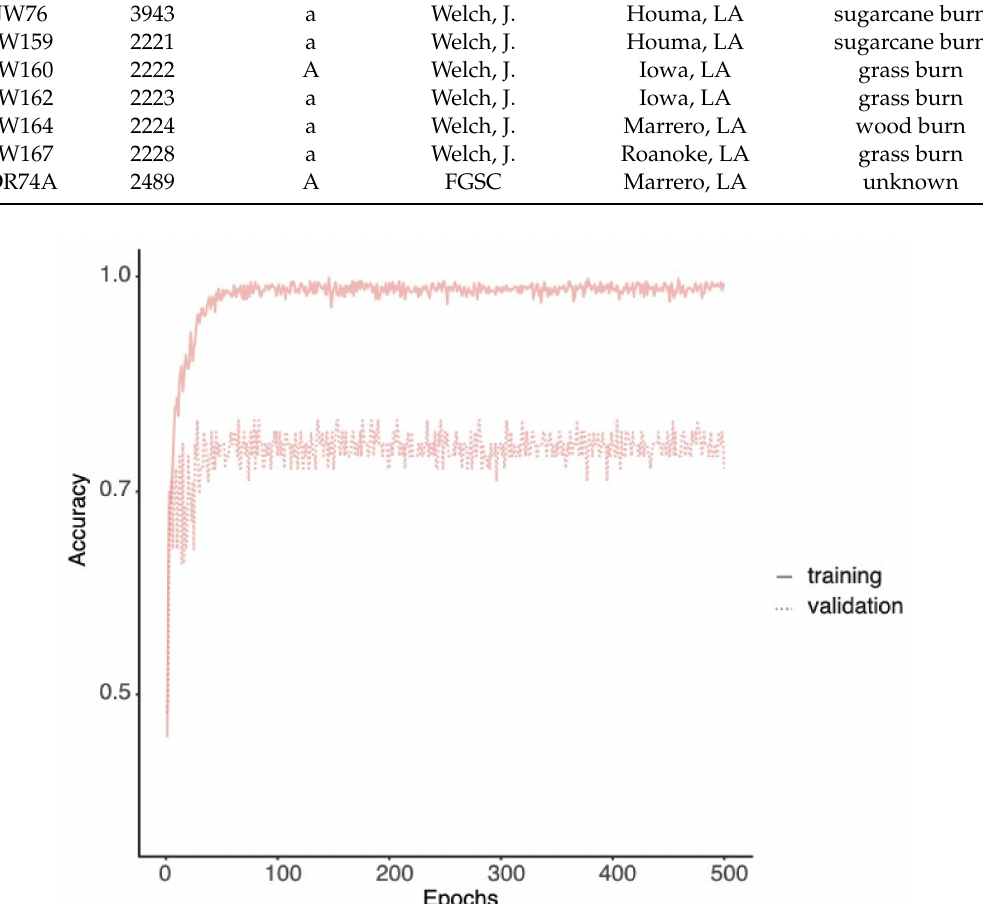
Figure A1. Model accuracies through training. Accuracies of the training (solid line) and validation (dotted line) sets is plotted through epochs. The final model was chosen on the basis of the accuracy of the validation